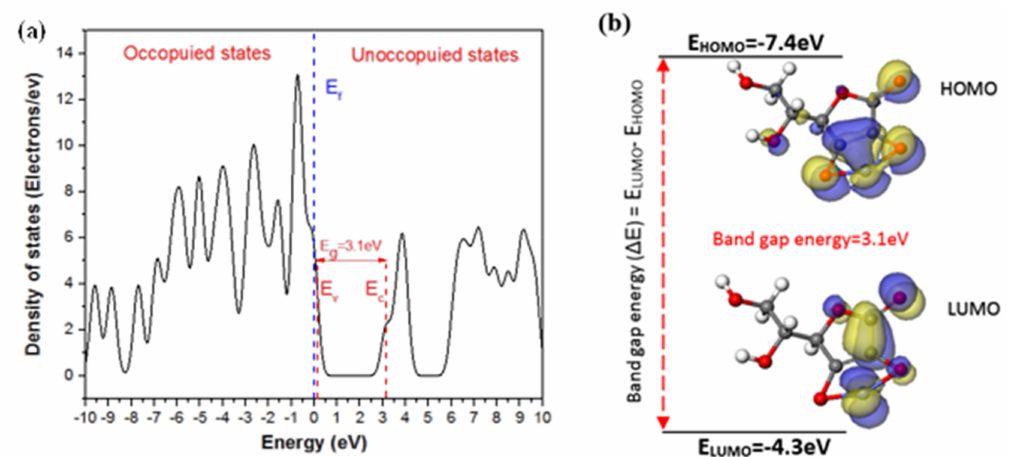
Figure 5. ( a ) The density of states (DOS) analysis of cobalt-ascorbate molecule calculated by DMol3, ( b ) HOMO, and LUMO orbitals of cobalt-ascorbate molecule with their corresponding band gap energy.